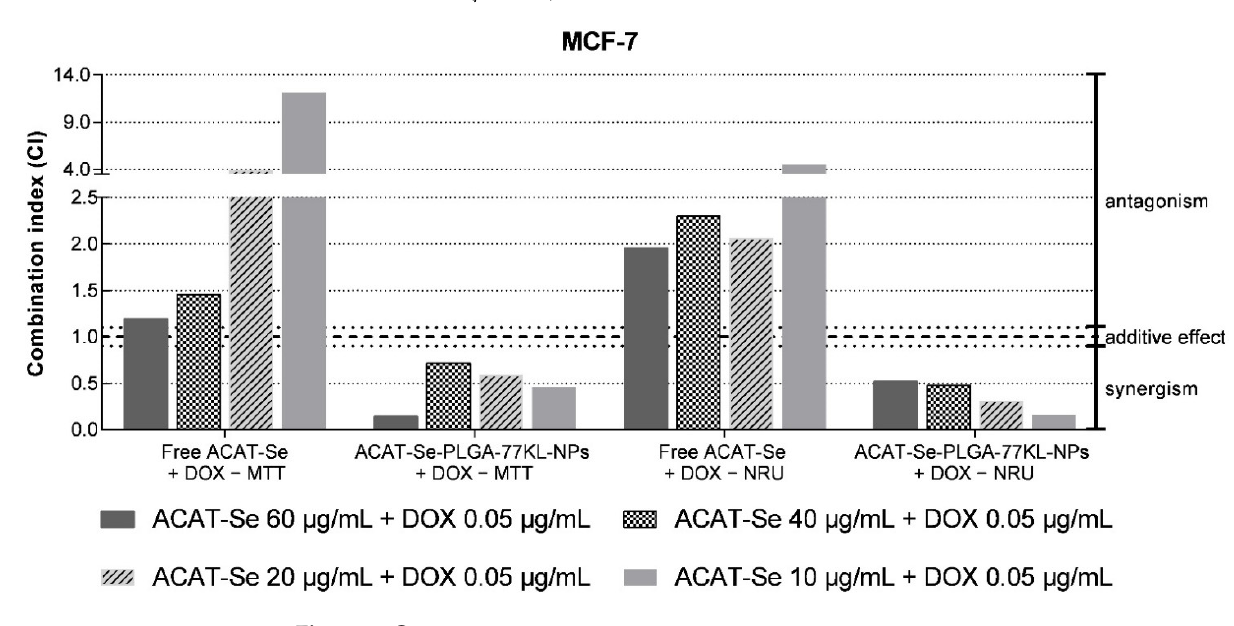
Figure 9. Combination index values for association of free ACAT-Se or ACAT-Se-PLGA-77KL-NPs with DOX in MCF-7 and NCI/ADR-Res cell lines. The association of PLGA-77KL-NPs (blank NPs without the organoselenium com- pound) and DOX resulted in low cytotoxic effects in both MCF-7 (cell viability between 74–80% and 79–83%, by MTT and NRU assay, respectively) and NCI/ADR-RES cells (cell viability between 83–87% and 69–79%, by MTT and NRU assay, respectively) (Figure S1, Supplementary Materials). Moreover, the CI values indicated that this association results in antagonism (CI > 1.1) in MCF-7 cells, by both MTT and NRU assays, in all tested con- centrations. Likewise, in NCI/ADR-RES cells, the association of PLGA-77KL-NPs and DOX displayed antagonism by MTT assay and antagonism (40 and 60 μ g/mL) or additive effect (10 and 20 μ g/mL) by NRU assay (Figure S2, Supplementary Materials).